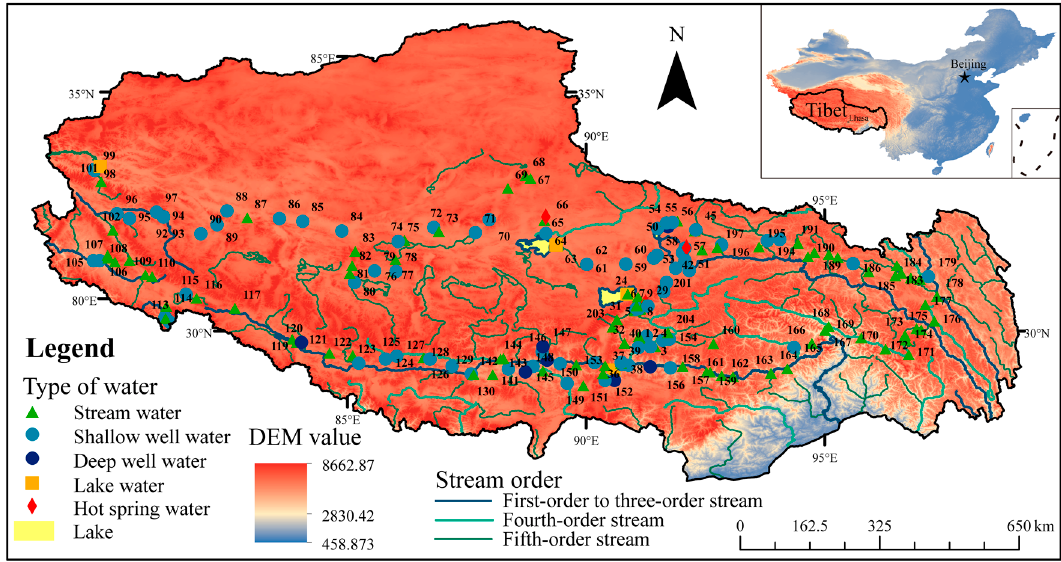
Figure 1. Geographical location, different types of water, and distribution of water sampling points in Tibet.